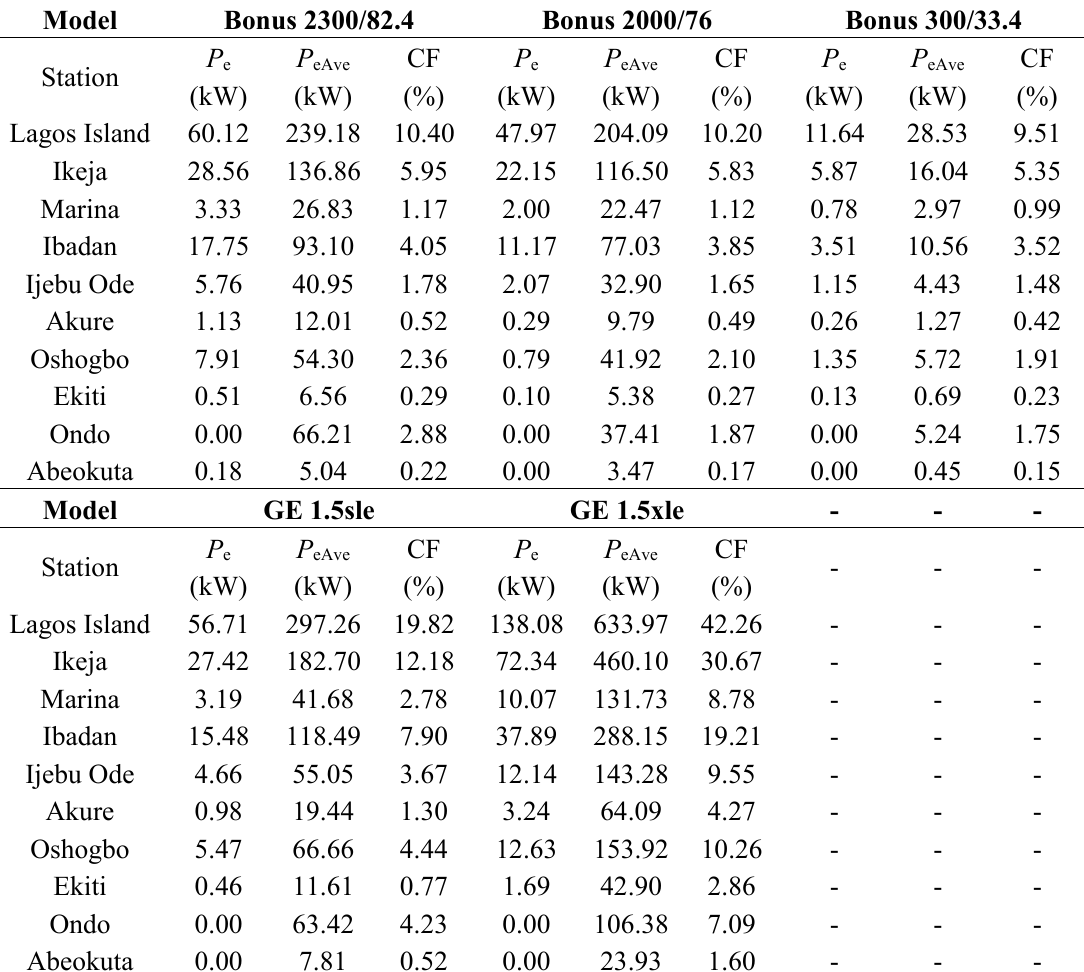
Table 4. Results of simulating electrical power output of a model wind turbine.